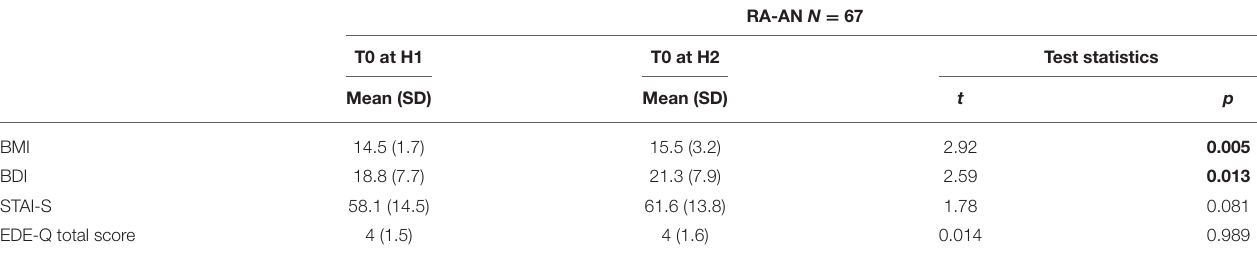
TABLE 2 | Differences across baseline and second hospitalization for patients with AN reporting (RA-AN) or not (non-RA-AN) readmissions after baseline